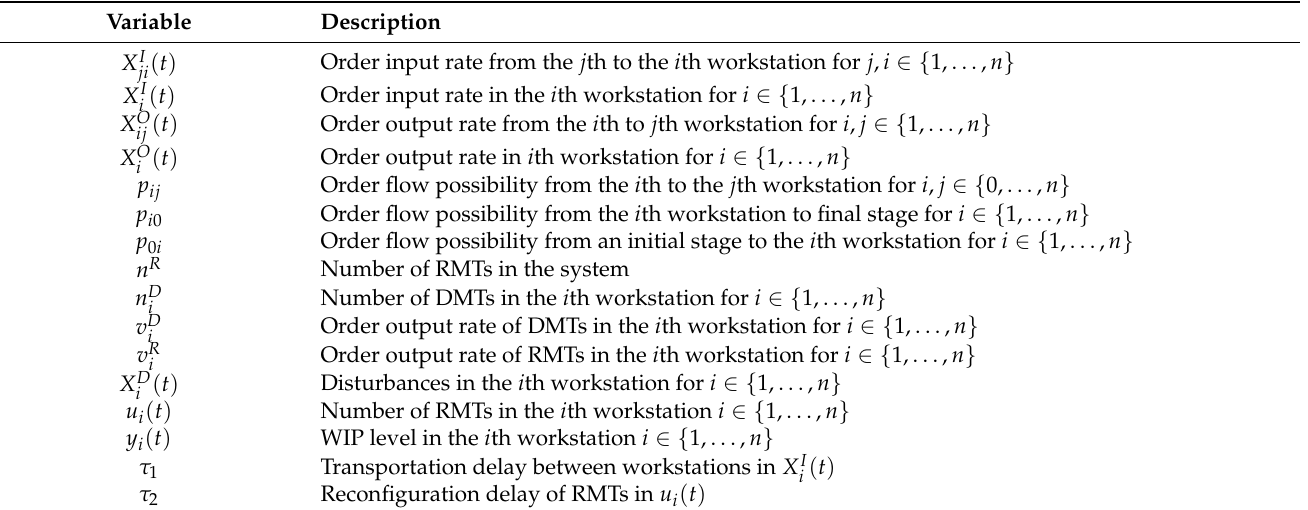
Table 1. Variables within a job shop system with